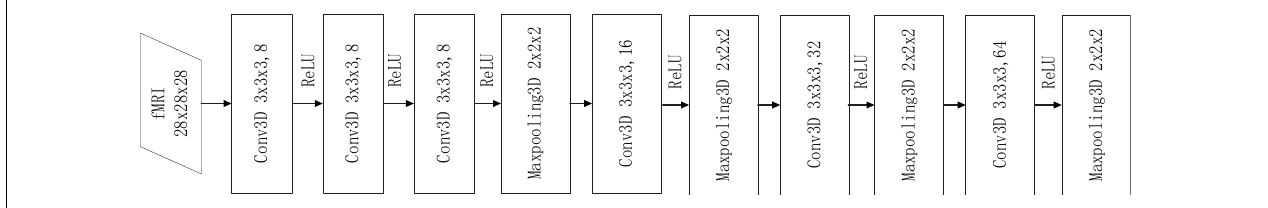
FIGURE 2 | The structure of single-frame convolutional neural network